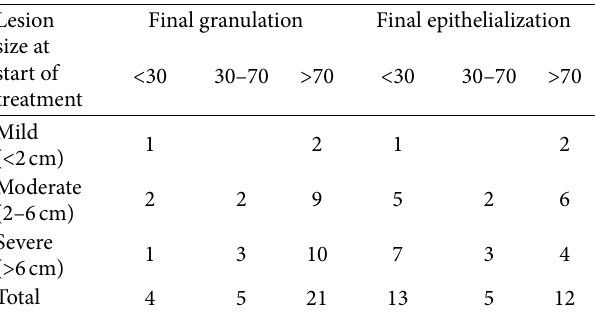
Figure 10: Comparison initial pain vs. final pain rating Table 9: Final results by lesion size.